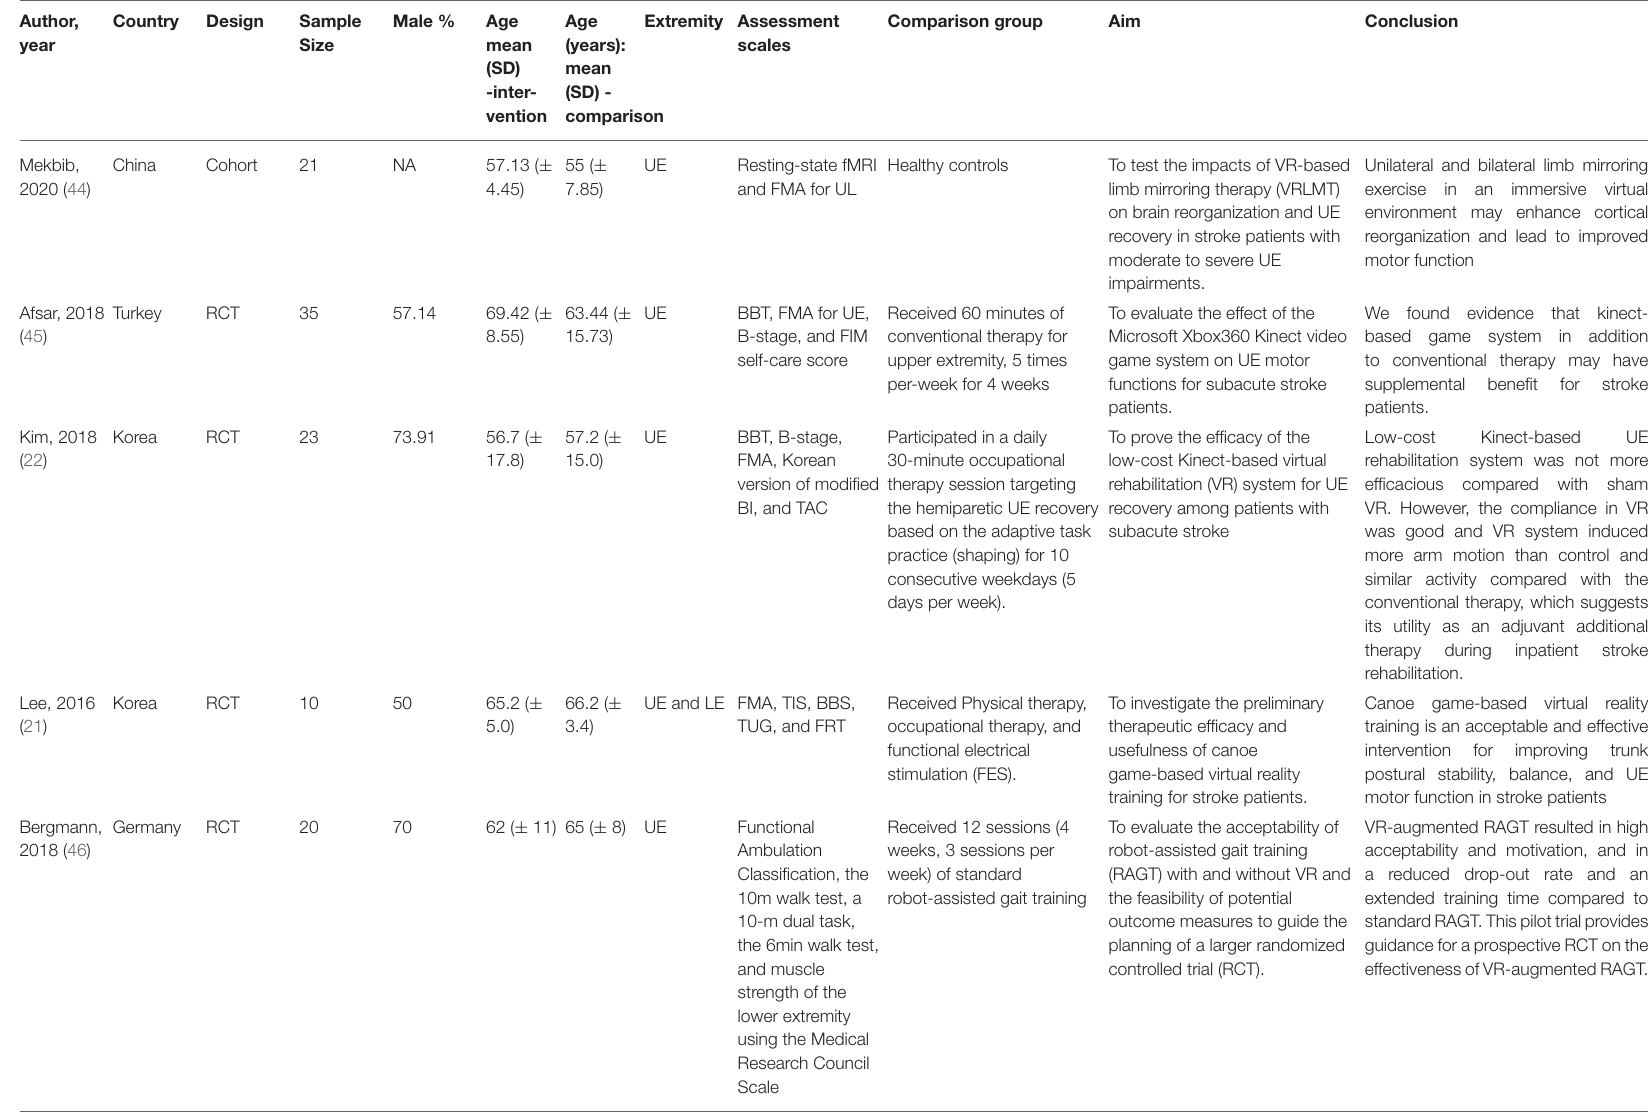
TABLE 1 | Baseline characteristics of included studies assessing VR in subacute stroke